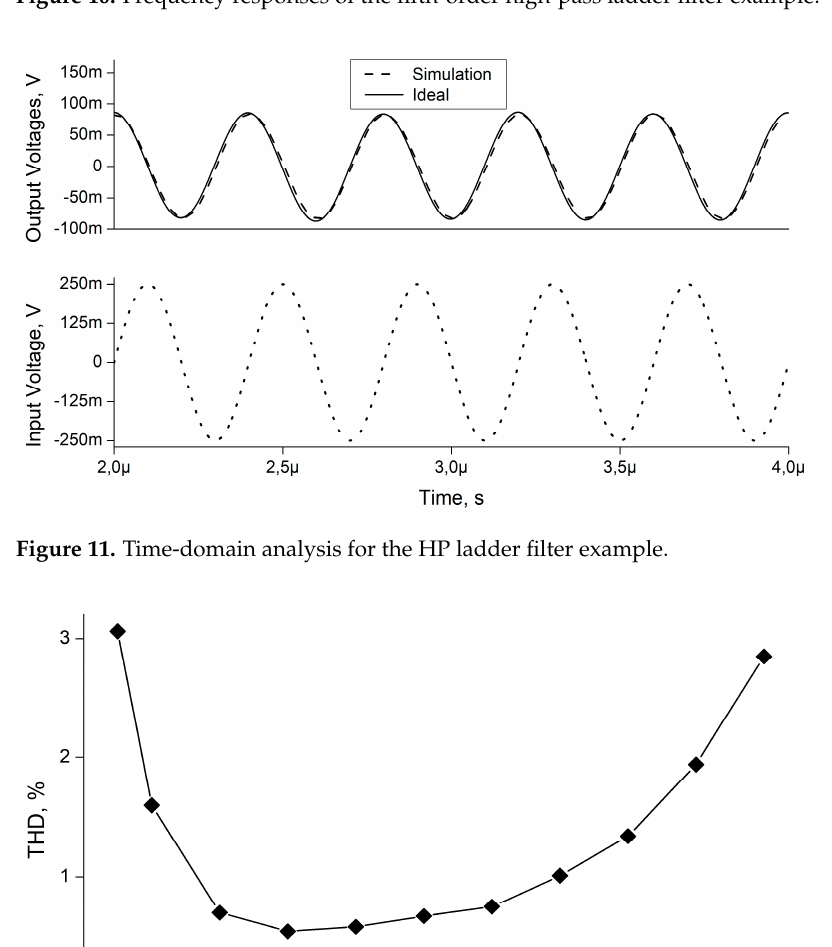
Figure 10. Frequency responses of the fifth-order high-pass ladder filter example.